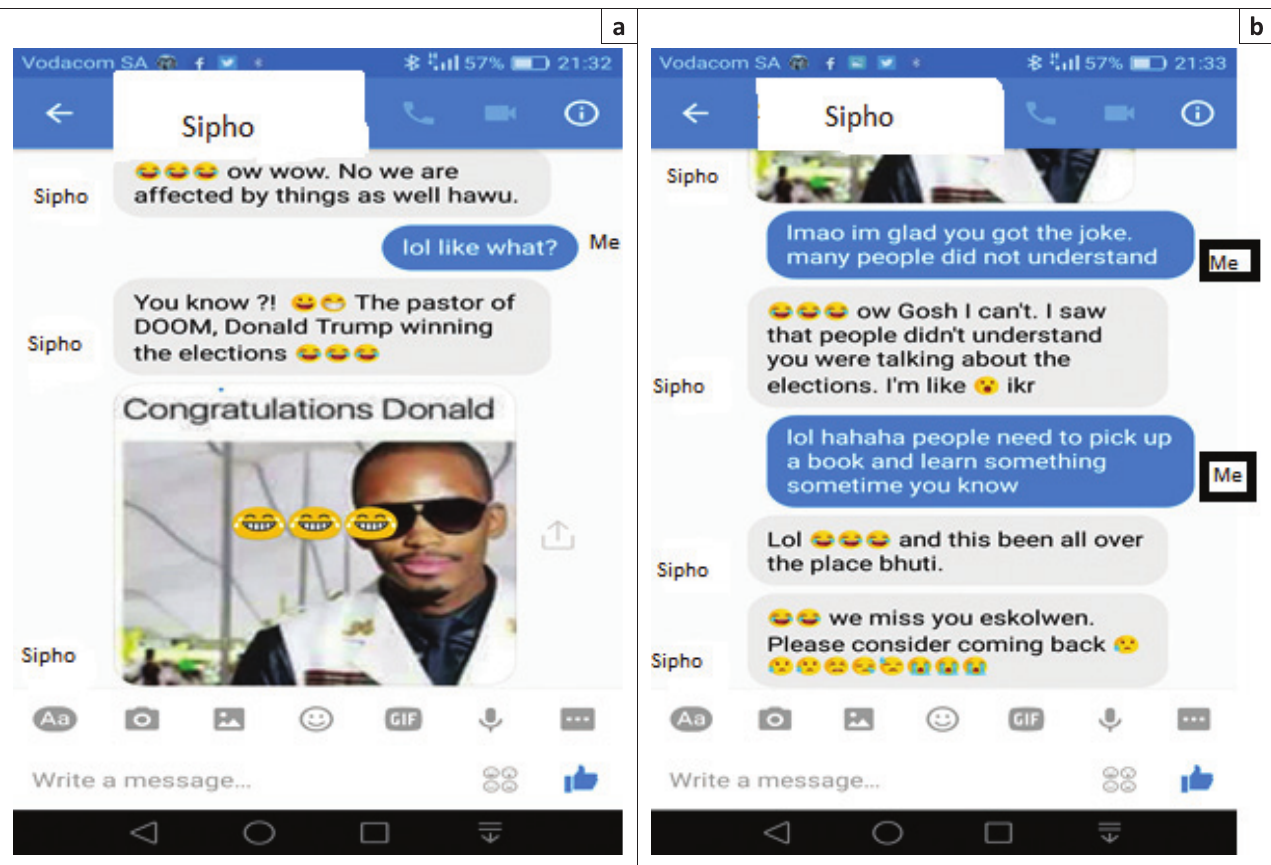
FIGURE 3: Screenshot conversation: (a) Online first discussion, and (b) online second